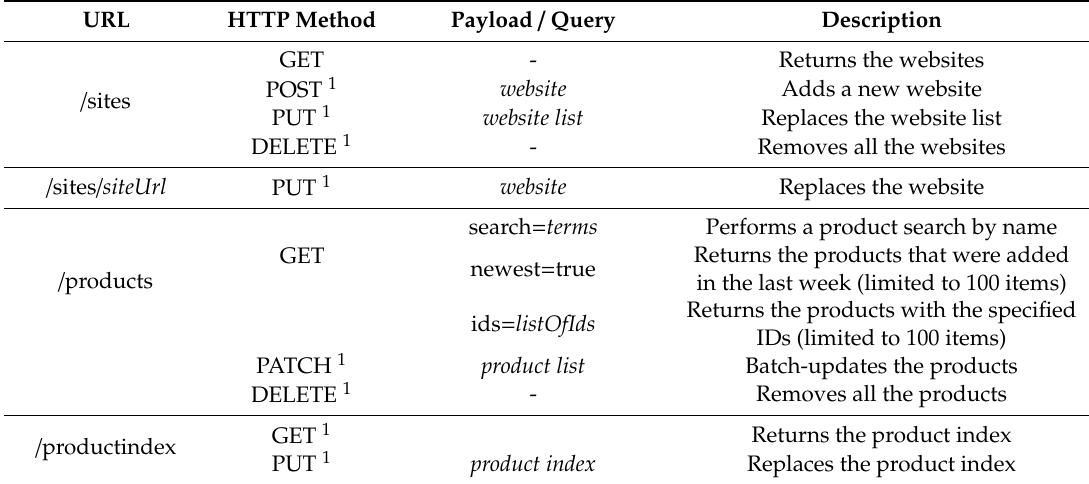
Table 2. Exposed RESTful micro web services at the presentation